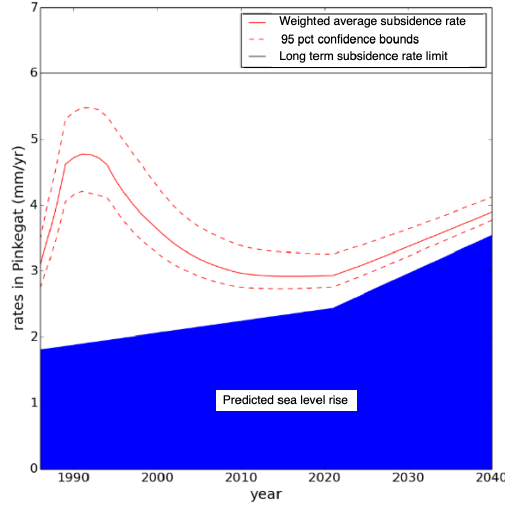
Figure 6. Posterior scenarios within the 95% confidence band stay below the long-term average subsidence rate limit (© NAM; source: NAM, 2017, Fig. 62).